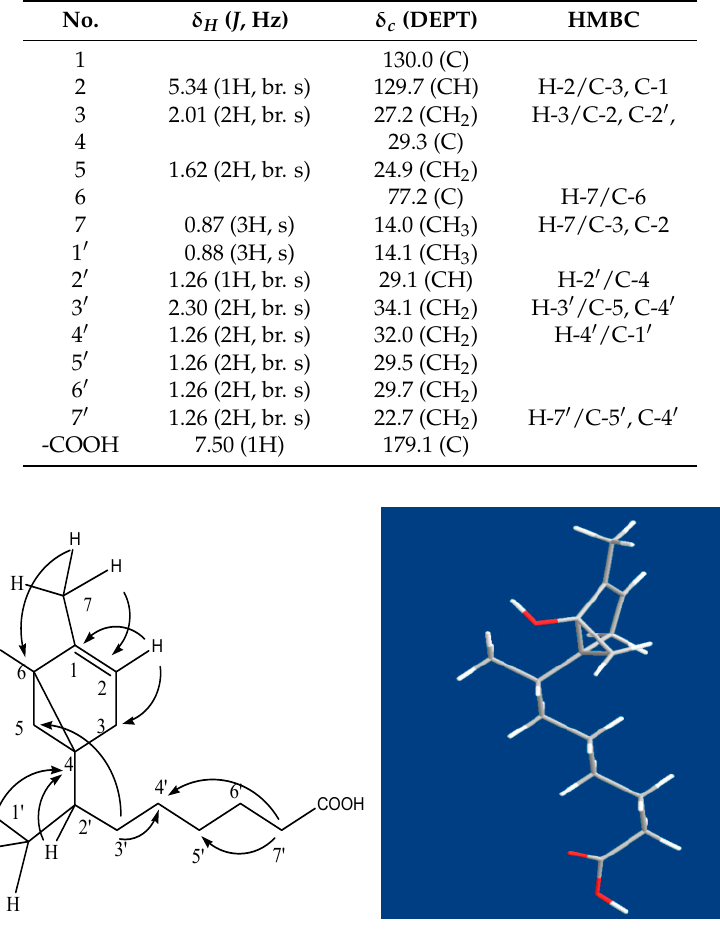
Figure 6. Key HMBC correlations of compound 3 .